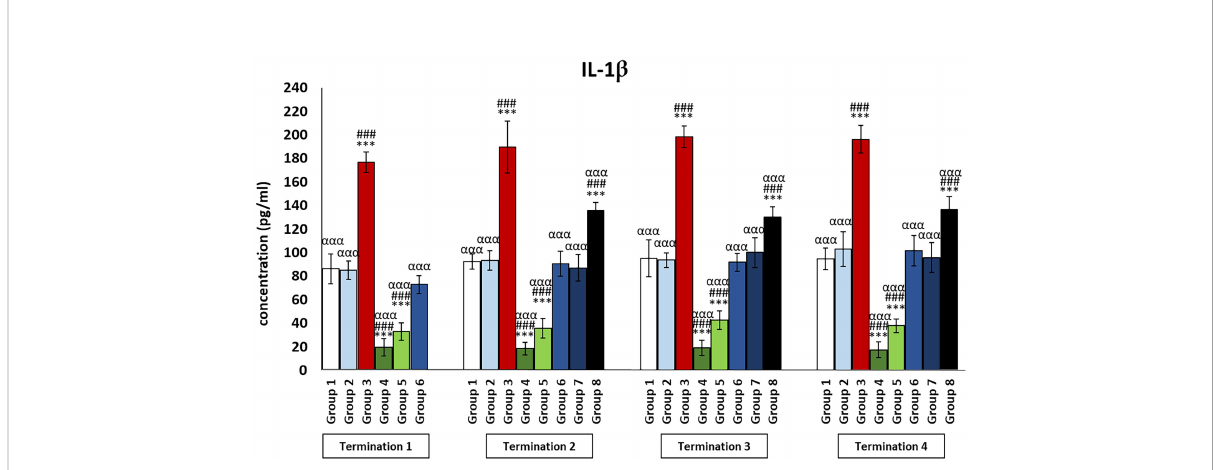
FIGURE 3 Changes in the levels of IL-1 b in the blood of chickens receiving phage therapy or antibiotic therapy after 6, 20, 28, and 34 days of experiments. Results are presented as mean values ± SD. Statistical analyses were performed by Kruskal – Wallis test and post-hoc Dunn test or ANOVA and post-hoc Tukey ’ s test. The signi fi cance of differences between controls and particular treated groups is observed and marked by the following: asterisks (*) vs. saline control; (#) vs. phage control (group 2); (a) vs. infected control (group 3); (g) vs. termination 2. p < 0.001 (***, ###, aaa ).